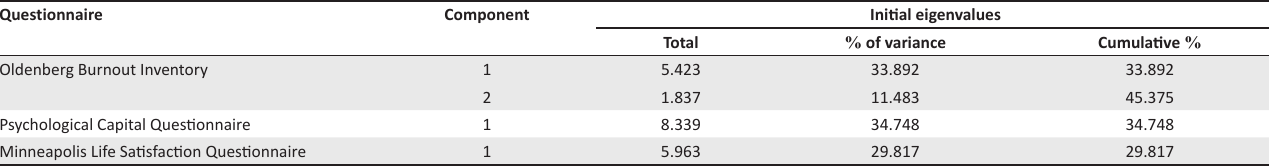
TABLE 2: Initial eigenvalues for the total variances explained.